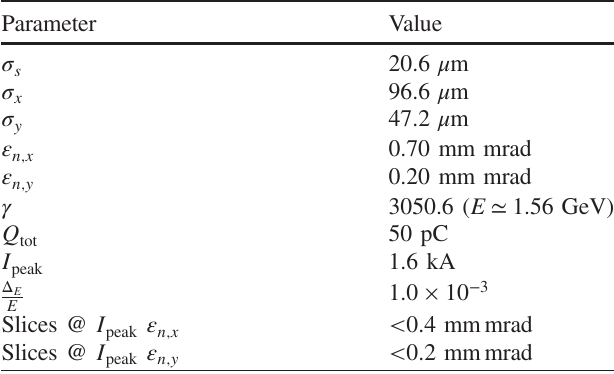
TABLE V. Beam parameters at the BAC matching line